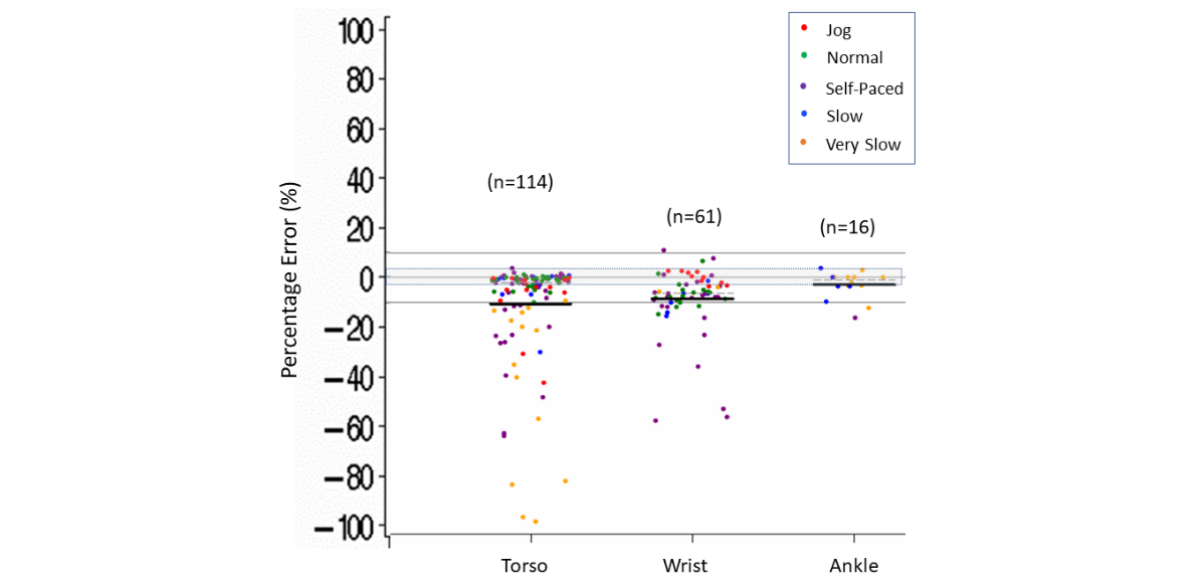
Figure 4. Step count percentage error in controlled settings. Body placement (torso, wrist, ankle) of the Fitbit device by speed (jog, normal, self-paced, slow, very slow). Dark lines indicate mean (horizontal). Dashed lines indicate median (horizontal). Gray shading indicates ±3% measurement error.